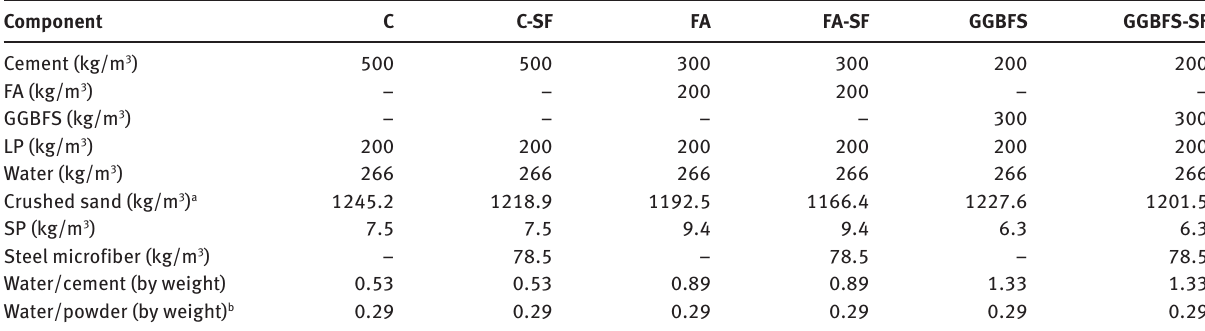
Table 3 Mortar mixture